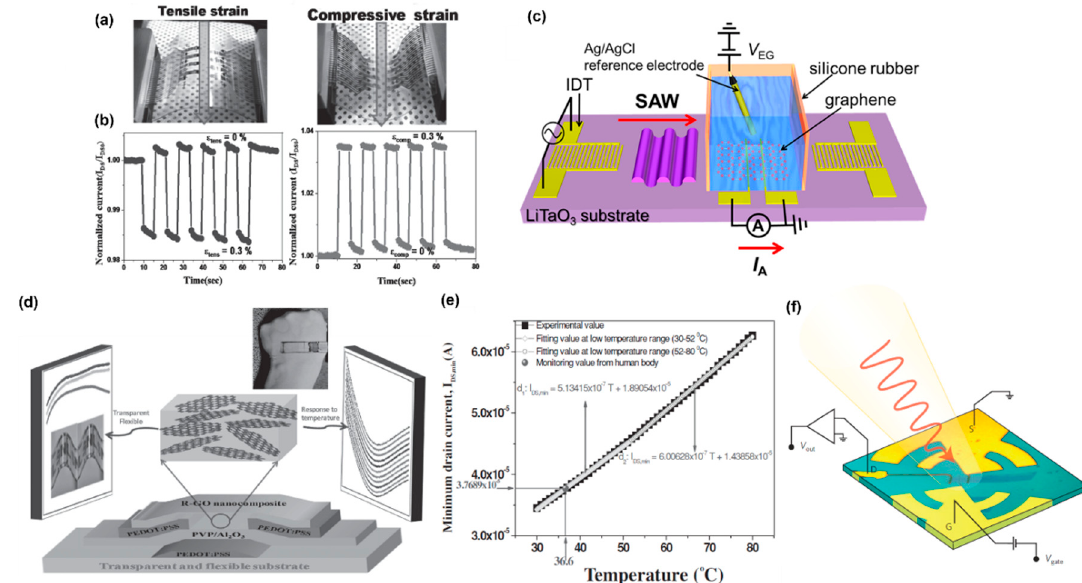
Figure 9. ( a ) Image of rGO FET subject to compressive and tensile strain. ( b ) The response of I d of the rGO FET strain sensor to compressive and tensile strain. ( c ) Design of graphene FET SAW sensor. ( d ) Flexible and wearable rGO / P(VDF- TrFE) nanocomposite temperature sensor. Insert: Photograph of the sensor worn on human skin. ( e ) Measurement of body temperature shown by I d . ( f ) Graphene FET terahertz detector. Reprinted with permission from References [122,124,130,131].